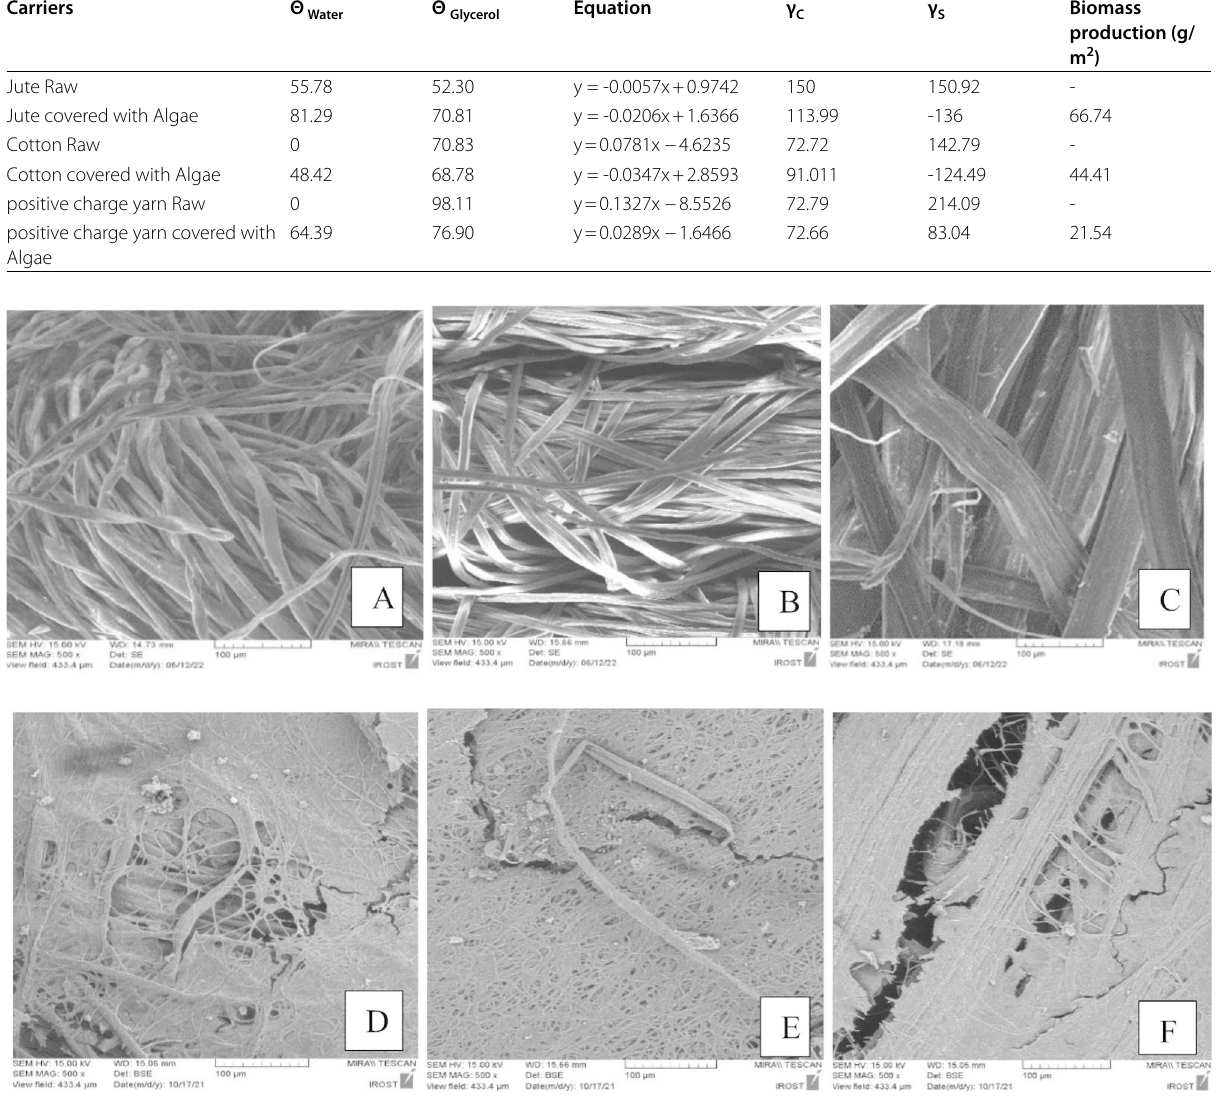
Fig. 6 FESEM micrographs of raw carrier and algal attachment on cotton, yarn and jute. ( A ) raw cotton ( B ) raw yarn. ( C ) raw jute. ( D ) cotton covered by cyanobacterium cells. ( E ) yarn covered by cyanobacterium cells and, ( F ) jute covered by cyanobacterium cells. The experiments were tested under rotat- ing